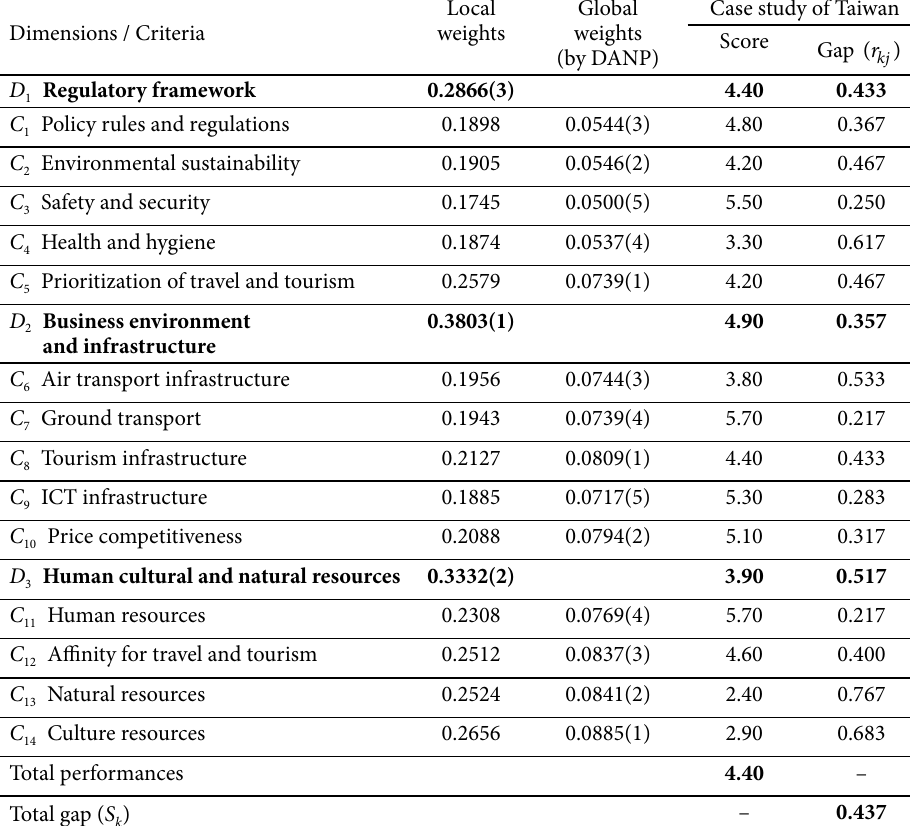
Table 3. The performance evaluation of the case study by VIKOR Dimensions / Criteria